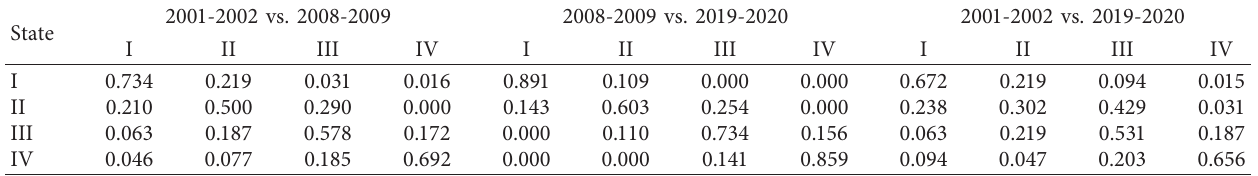
Table 2: Markov transition probability matrix of Chinese export comparative advantage.